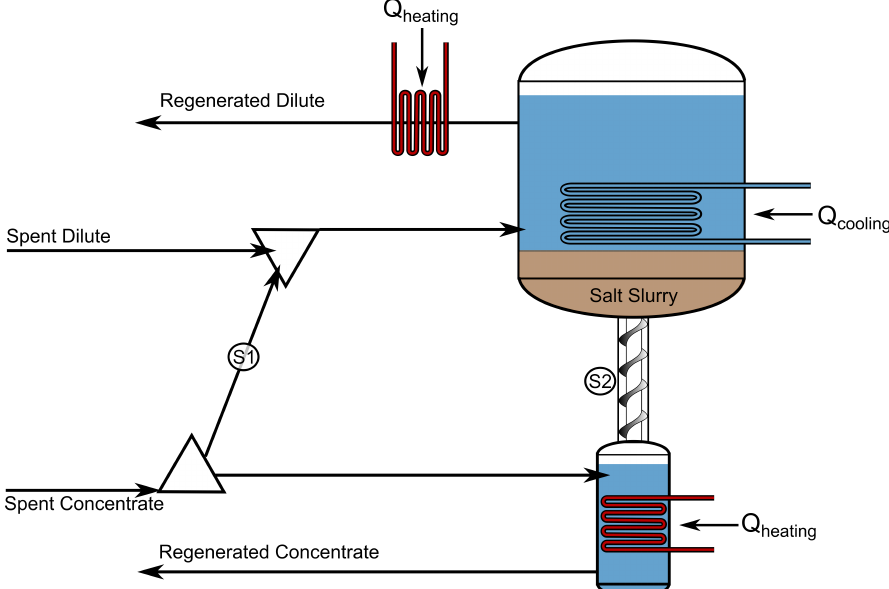
Figure 3. Conceptual sketch of the precipitation regeneration stage with spent dilute and concentrate coming from the outlet of the RED stack. Pumps required for solution propulsion are not shown. Water and salt are exchanged between spent concentrate and dilute through S 1 and S 2, in amounts depending on the slurry concentration and the state of the spent